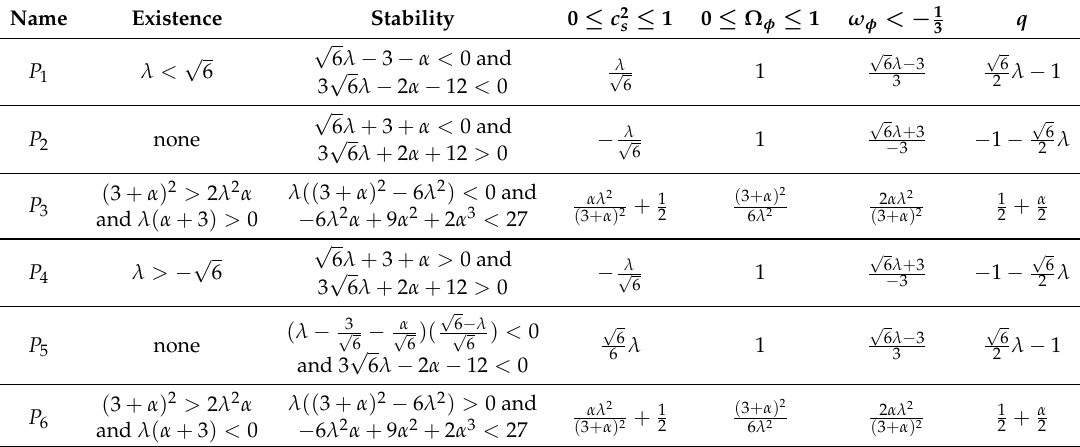
Table 1. The existence and stability conditions for six critical points, and the cosmological quantities in form of the parameters λ and α in each critical